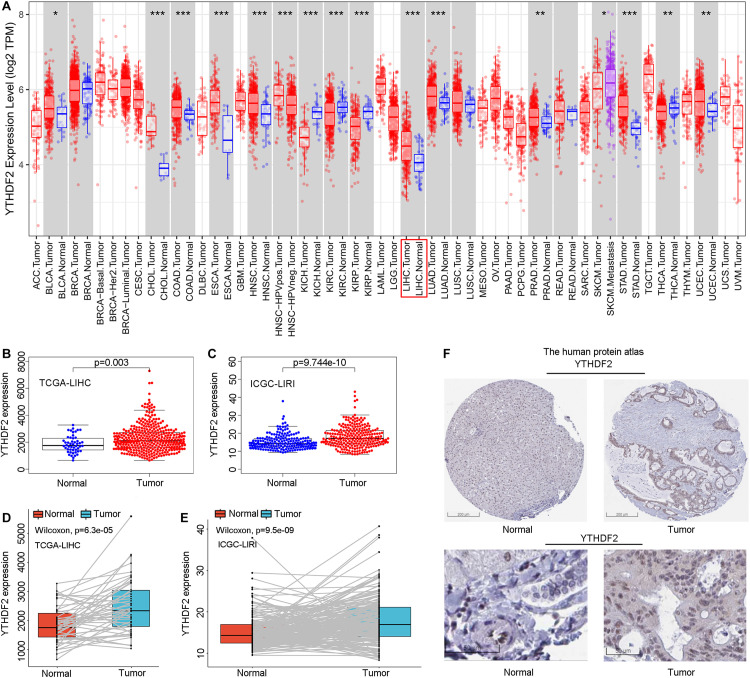
Pooled analyses of YTH domain family (YTHDF) 2 expression in liver hepatocellular carcinoma (LIHC). (A) YTHDF2 expression in different cancer types via the Tumor Immune Estimation Resource (TIMER) database. (B) YTHDF2 expression in 374 LIHC patients and 50 normal samples [The Cancer Genome Atlas (TCGA)-LIHC]. (C) YTHDF2 expression in 243 LIHC patients and 202 normal samples [International Cancer Genome Consortium (ICGC)-LIRI]. (D) YTHDF2 expression in 50 paired LIHC tissues and corresponding adjacent non-tumor tissues (TCGA-LIHC). (E) YTHDF2 expression in 199 paired LIHC tissues and corresponding adjacent non-tumor tissues (ICGC-LIRI). *P < 0.05, **P < 0.01, ***P < 0.001. (F) Expression of YTHDF2 protein in LIHC tissues and normal liver tissues (HPA). Scale bars, 200 and 50 μm.